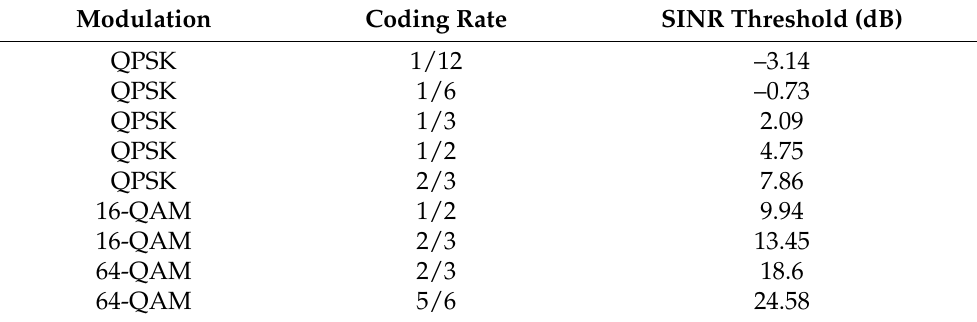
Table 1. MCS-levels accounting for received SINR [25].